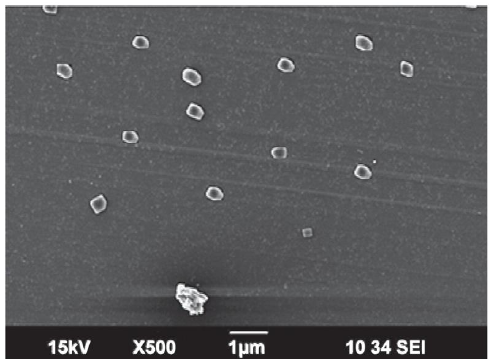
Figure 4. Representation of SEM findings of methotrexate-loaded nanoemulsion.